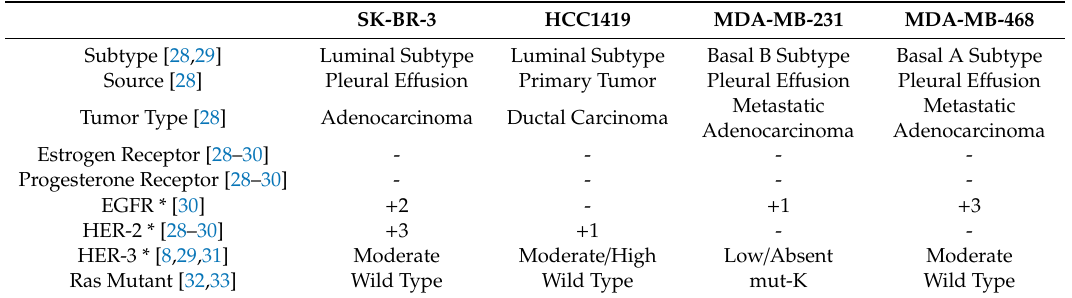
Table 1. Properties of the human breast cancer cell lines subjected to treatment.